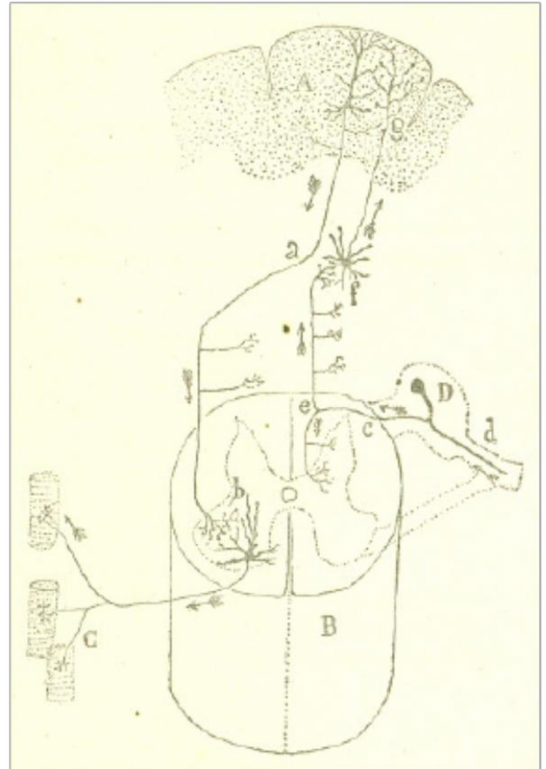
Figure 2. A scheme of the central motor pathway in the brain and the spinal cord. Pyramidal neurons in the motor area of the cerebral cortex (A) send signals directly to large neurons in the spinal cord (H) called motor neurons. These motor neurons send command signals to our muscles (C). The arrows represent the direction of the current. Taken from Cajal [6] (p. 6), out of